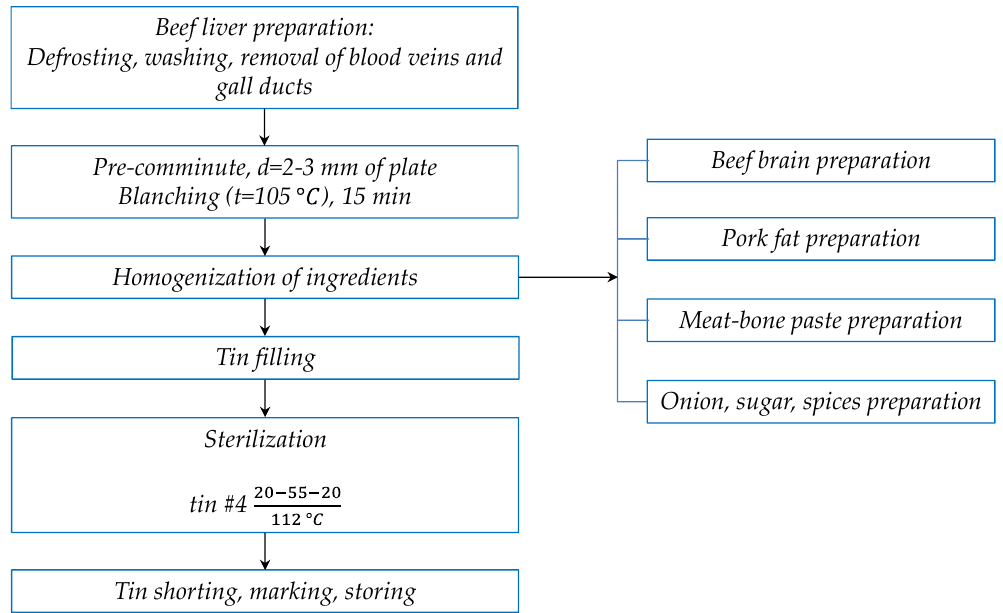
Figure 1. Flow sheet of liver pâté preparation.